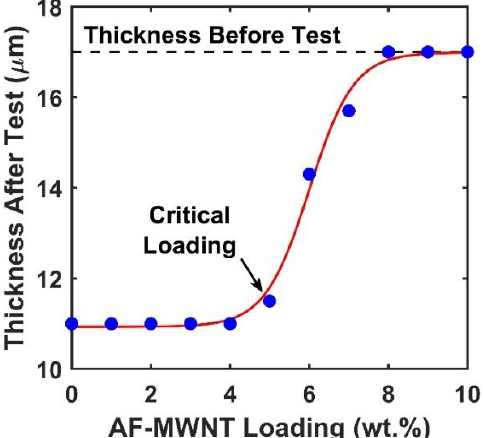
Figure 7. Effect of AF-MWNT loading on the membrane thickness after testing under 1.5-MPa feed pressure for 12 h. The red sigmoidal curve is the best fitted with a log function.